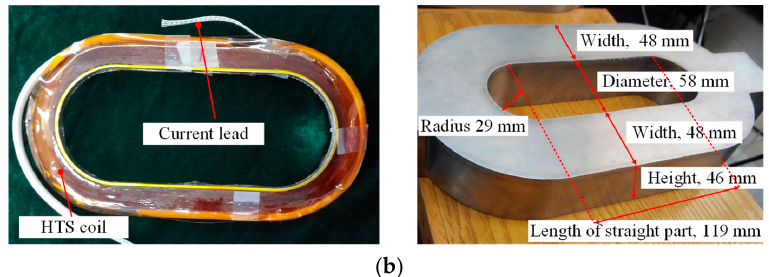
Figure 1. Configurations of the proposed high temperature superconducting (HTS) field-modulation double-stator (HTS-FMDS) machine: ( a ) cross-section and three-dimensional model and ( b ) HTS coil and its Dewar.